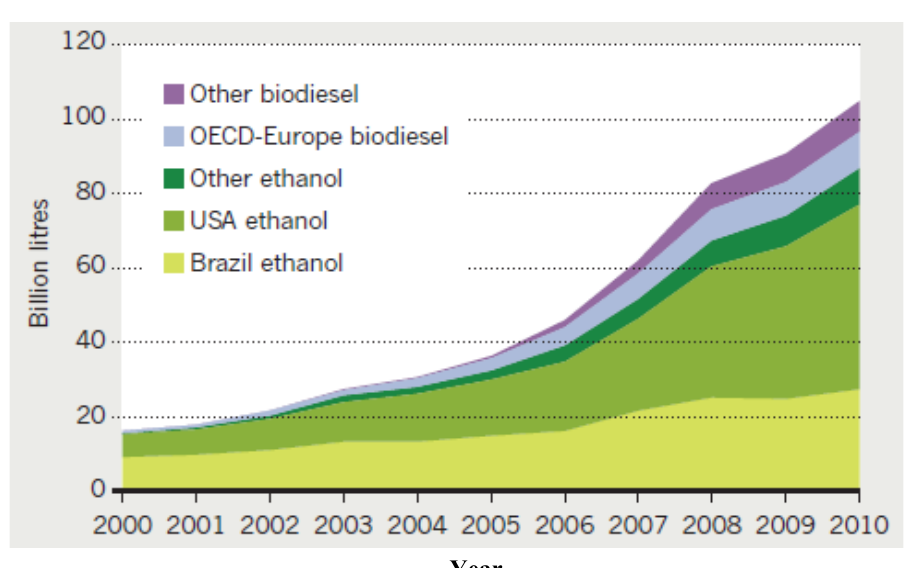
Figure 1. Global Biofuel Production. Reprinted with permission from [4]. Copyright OECD/IEA